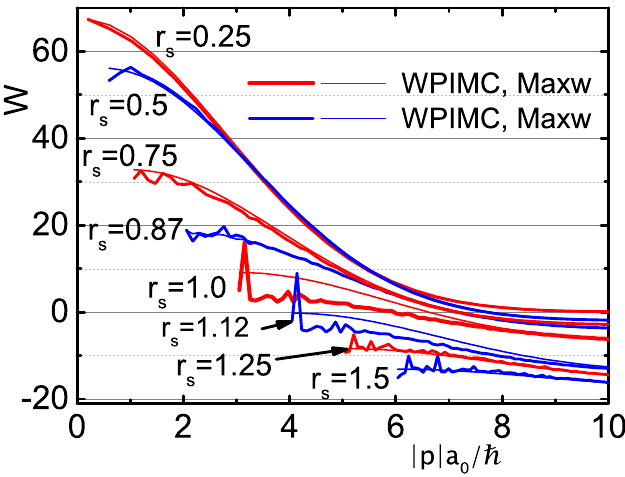
Figure 1. (Color online) The UEG electron momentum distribution functions W ( | p | a 0 /¯ h ) normalized to ( π / β Ry ) ( 3/2 ) at Θ = 4. Thick lines—WPIMC distributions, thin lines—Maxwell–Boltzmann distributions. For better representation, W ( | p | a 0 /¯ h ) for r s = 0.25 and r s = 0.5 are divided by 14 and 2,